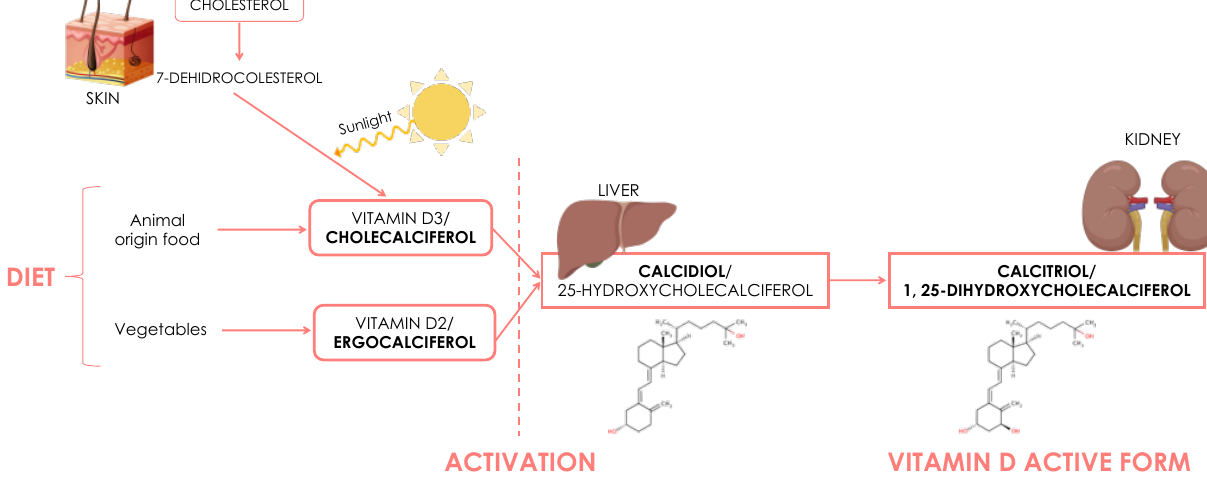
Figure 1. Vitamin D synthesis pathways.